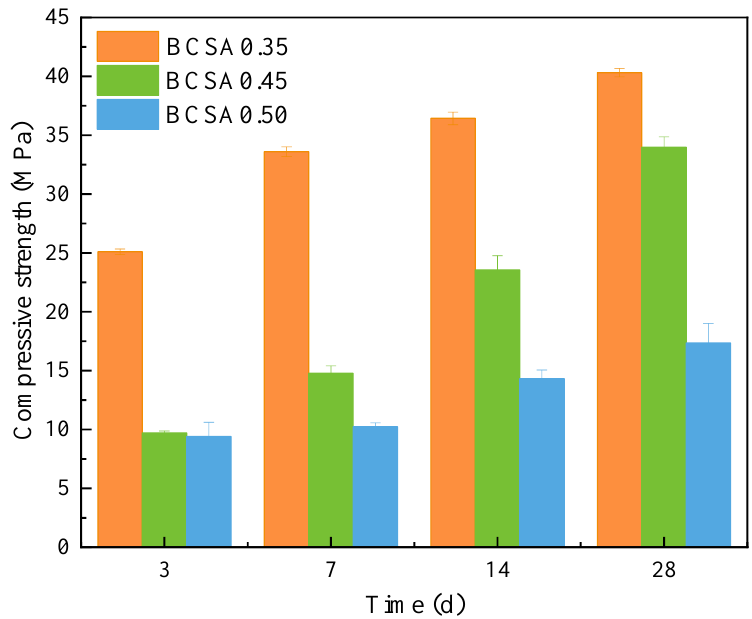
Figure 5. Compressive strength of BCSA pastes with different w / c ratios.